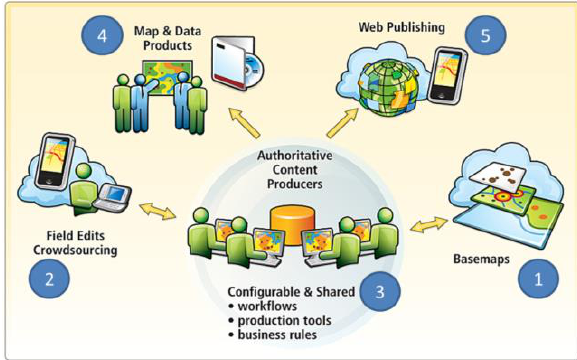
Figure 11 . Workflow of